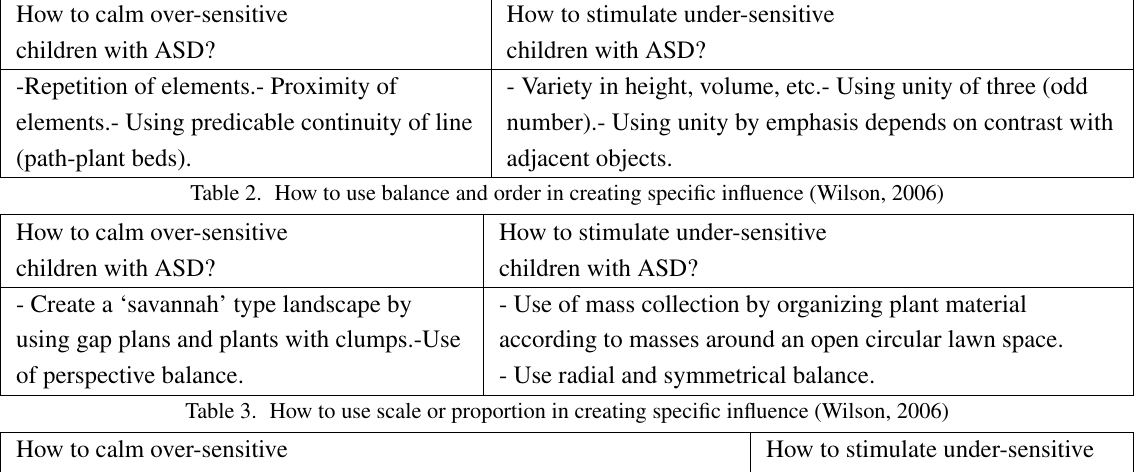
Table 3. How to use scale or proportion in creating specific influence (Wilson, 2006)